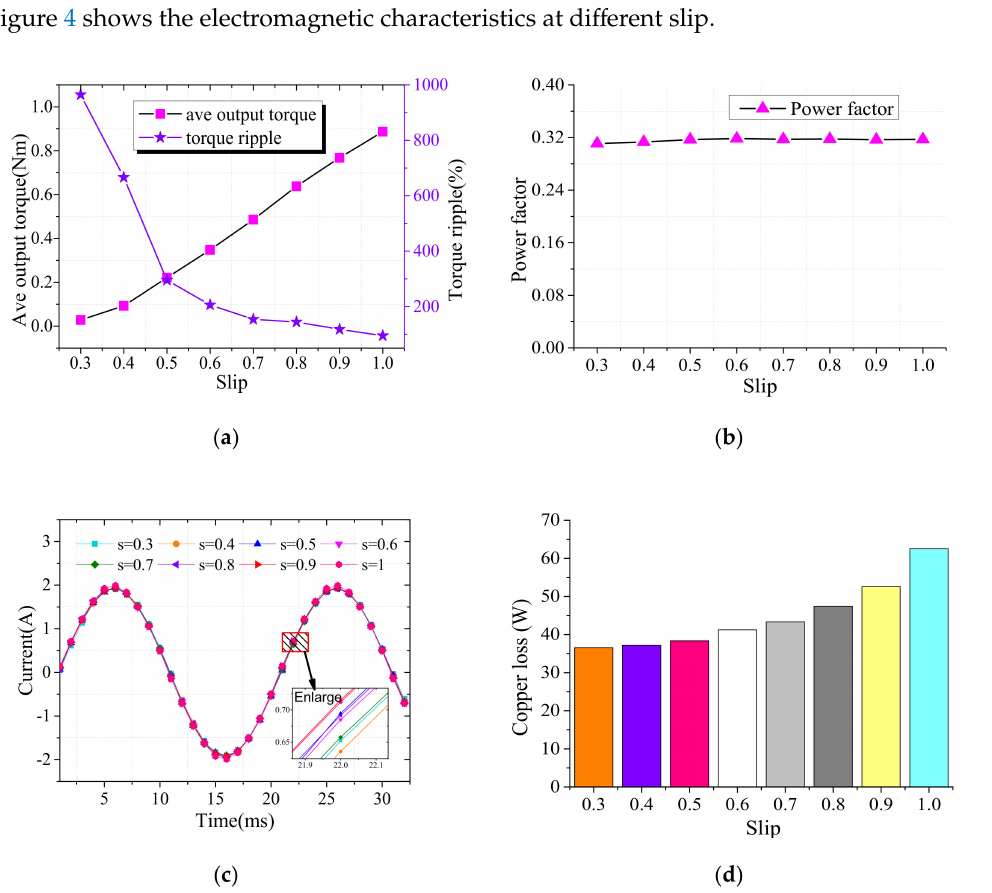
Figure 4. Electromagnetic characteristics at di ff erent slip. ( a ) Average output torque and torque ripple; ( b ) power factor; ( c ) stator current; and ( d ) copper